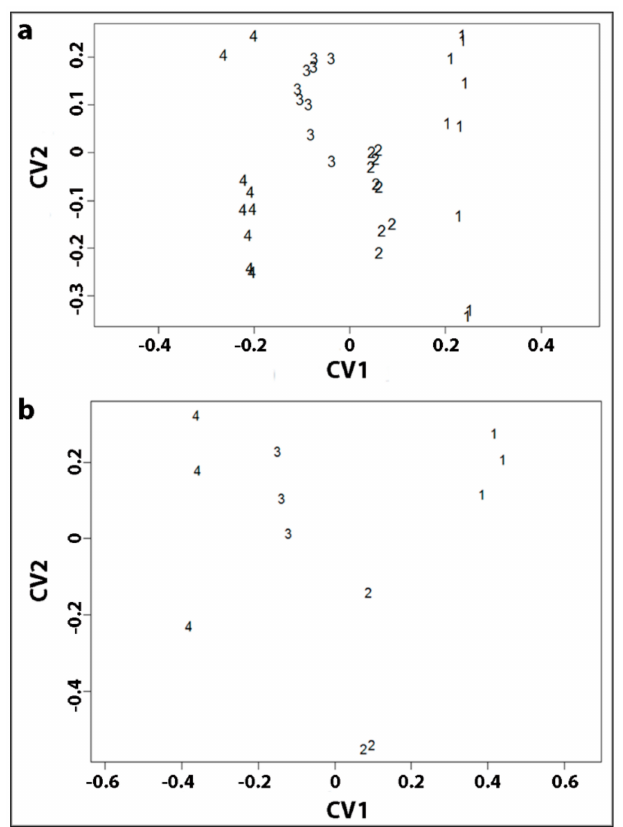
Figure 4. The canonical variate plot ( a ) Plot showing the separation of the four corewood types (1, OW; 2, MCW1; 3, MCW2; 4, SCW) from three trees defined by the first two canonical variates (CV1 and CV2) obtained from canonical correlation analysis conducted on a combination of tracheid shrinkage in the three directions (longitudinal, tangential and radial) and the chemical data (lignin content; percentage arabinose, galactose, xylose and mannose). ( b ) Plot showing the separation of the four corewood types from three trees defined by the first two canonical variates (CV1 and CW2) obtained from canonical correlation analysis conducted on a combination of tracheid wall shrinkage (longitudinal shrinkage and transverse shrinkage of the radial and of the tangential walls) and the chemical data (lignin content; percentage arabinose, galactose, xylose and